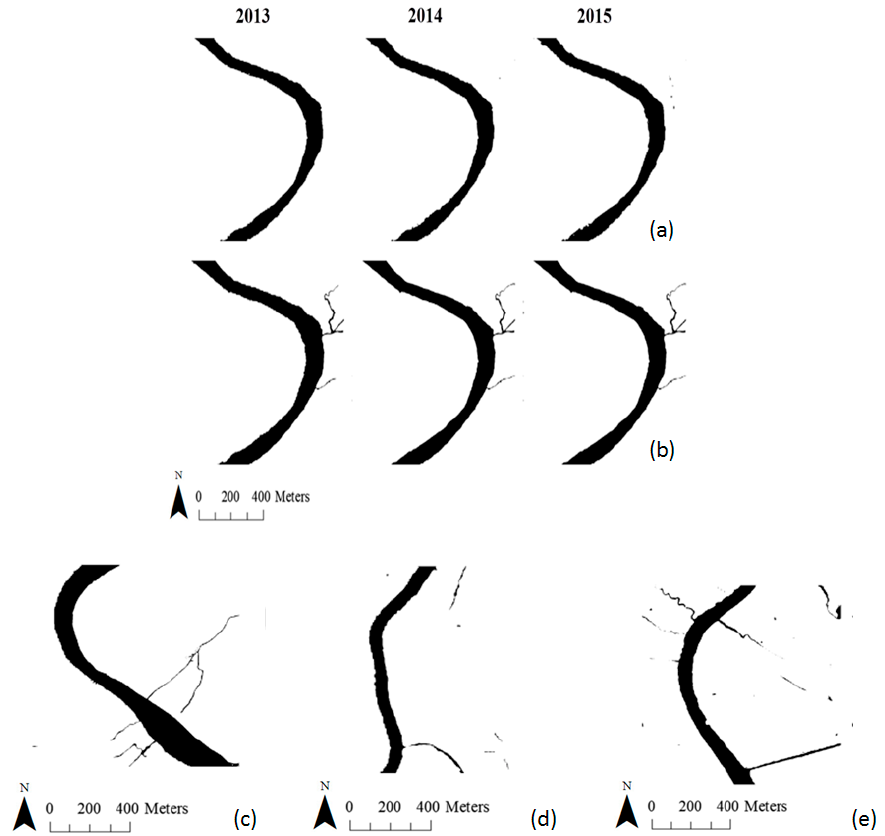
Figure 5. Water extraction results in Pathumthani for image one in 2013 to 2015 using: ( a ) Majority Voting; and ( b ) Dempster–Shafer. ( c ) Image two. ( d ) Image three; and ( e ) image four obtained in 2013 by Dempster–Shafer.